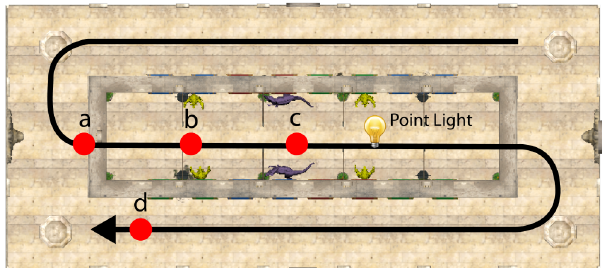
Fig. 4. Floor plan of the scene used in the tests, showing the 3D meshes of the armadillo and T-Rex dinosaurs, the light point position and the camera path: (a) Frame 1800, (b) Frame 2100, (c) Frame 2300 e (d) Frame